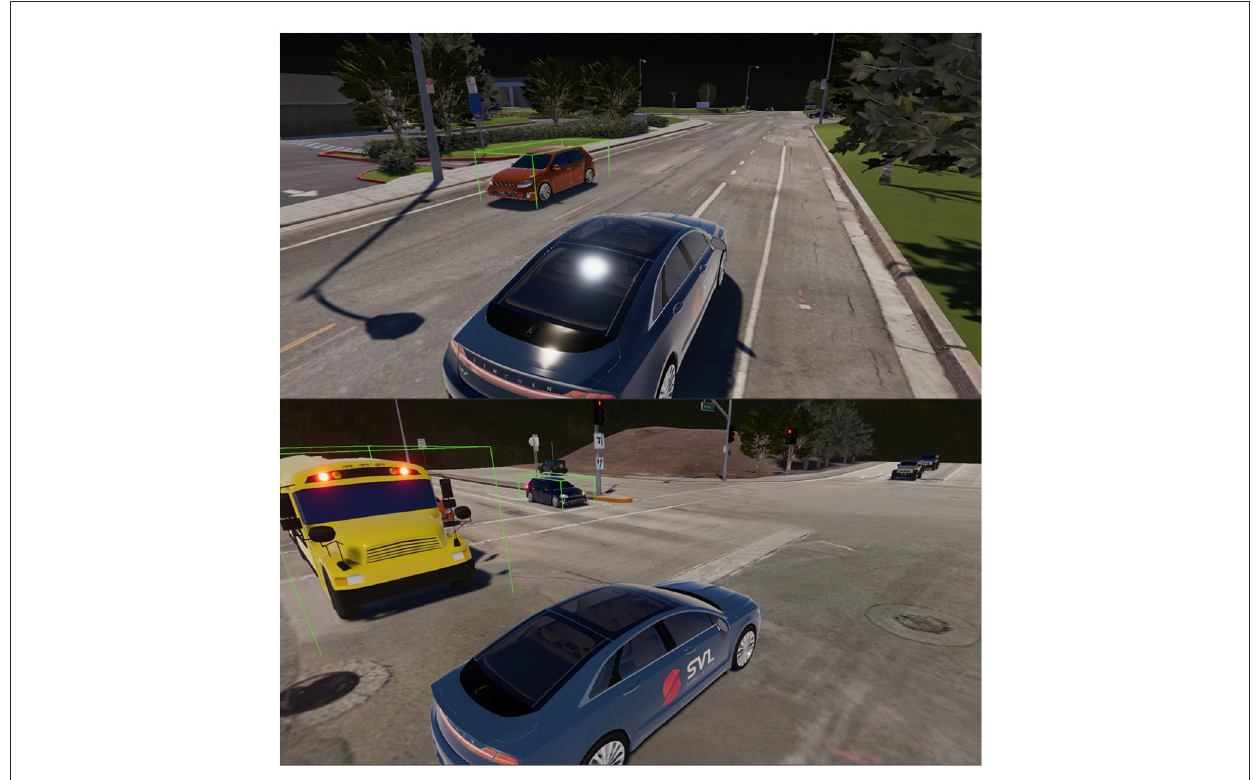
FIGURE6 Top : High predictability, low risk for accident scenario. Bottom : Low predictability high risk for accident scenario.